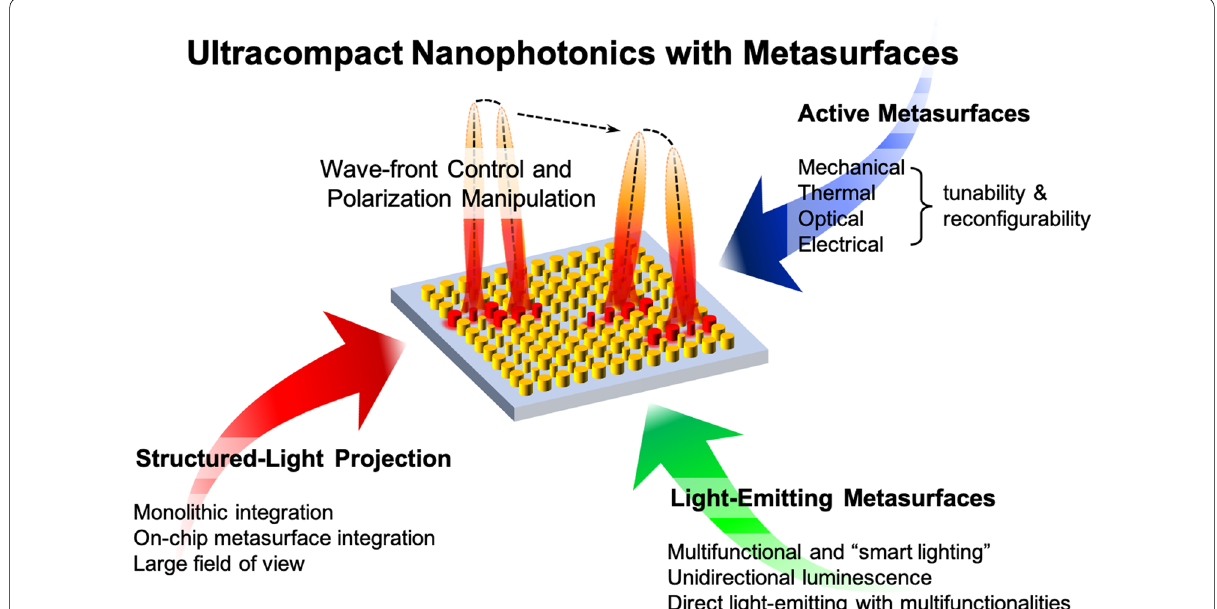
Fig. 1 Schematic organization of relevant topics in this